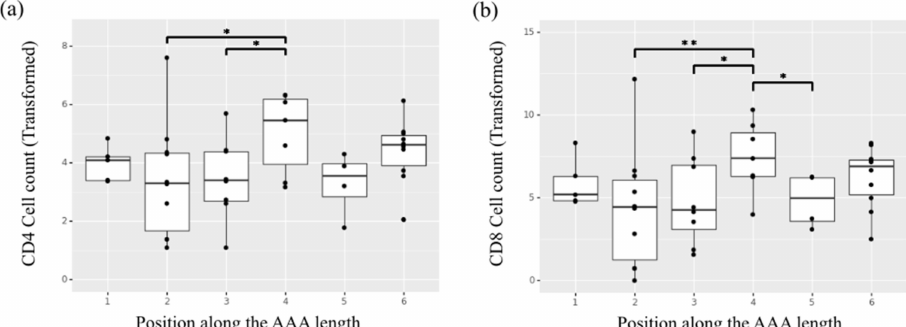
Figure 7. Heterogeneity of cell counts along the length of the AAA for the inflammatory infiltrates ( a ) helper T-cells (CD4+) and ( b ) cytotoxic T-cells (CD8+) in the adventitia layer of the selected samples undergoing ex vivo immunohistochemical analysis. * indicates p value < 0.05, ** indicates p value <